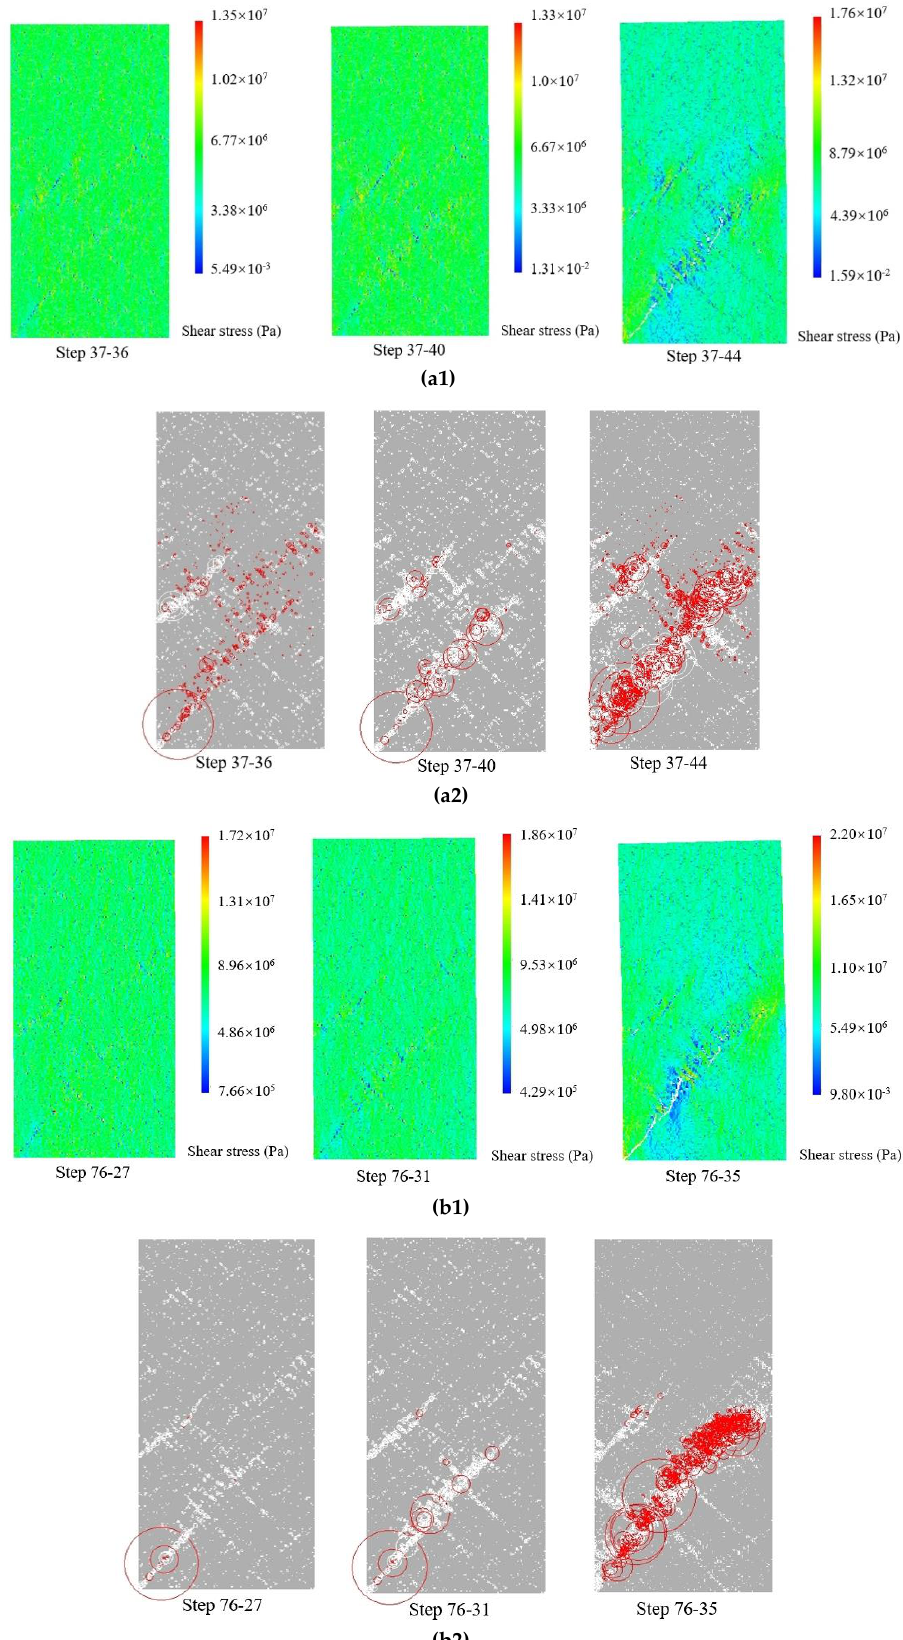
14 of 28 Figure 9. Model load diagram. Table 3. Basic parameters of the model. Homogeneous